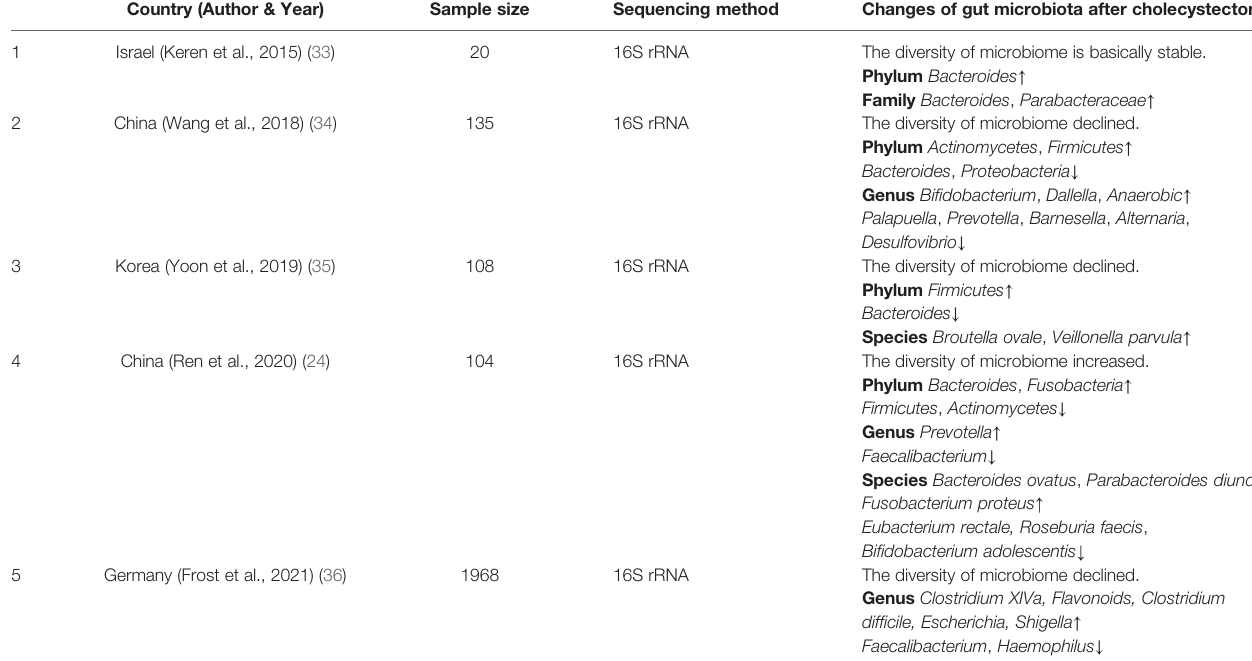
TABLE 1 | Comparison of gut microbiota between patients who have undergone cholecystectomy and healthy individuals. Country (Author &